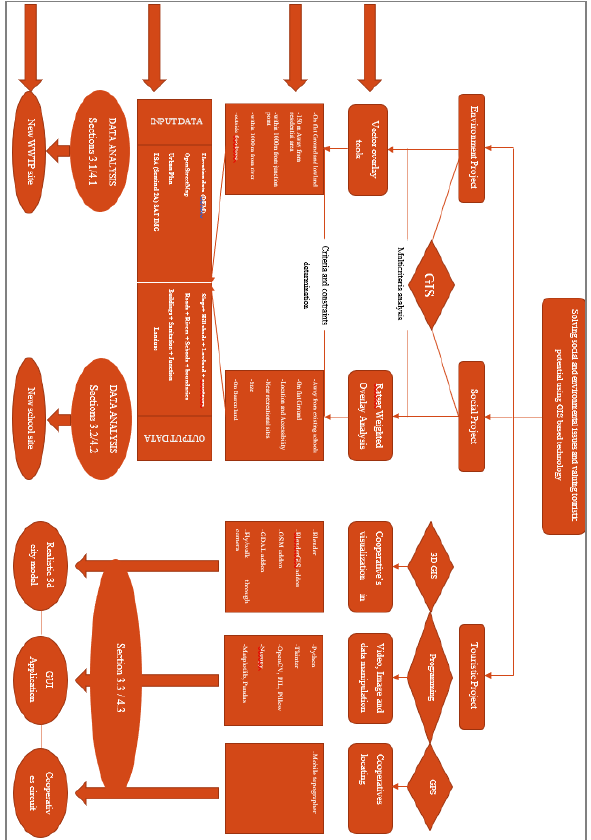
Figure 2 . Global methodology of the